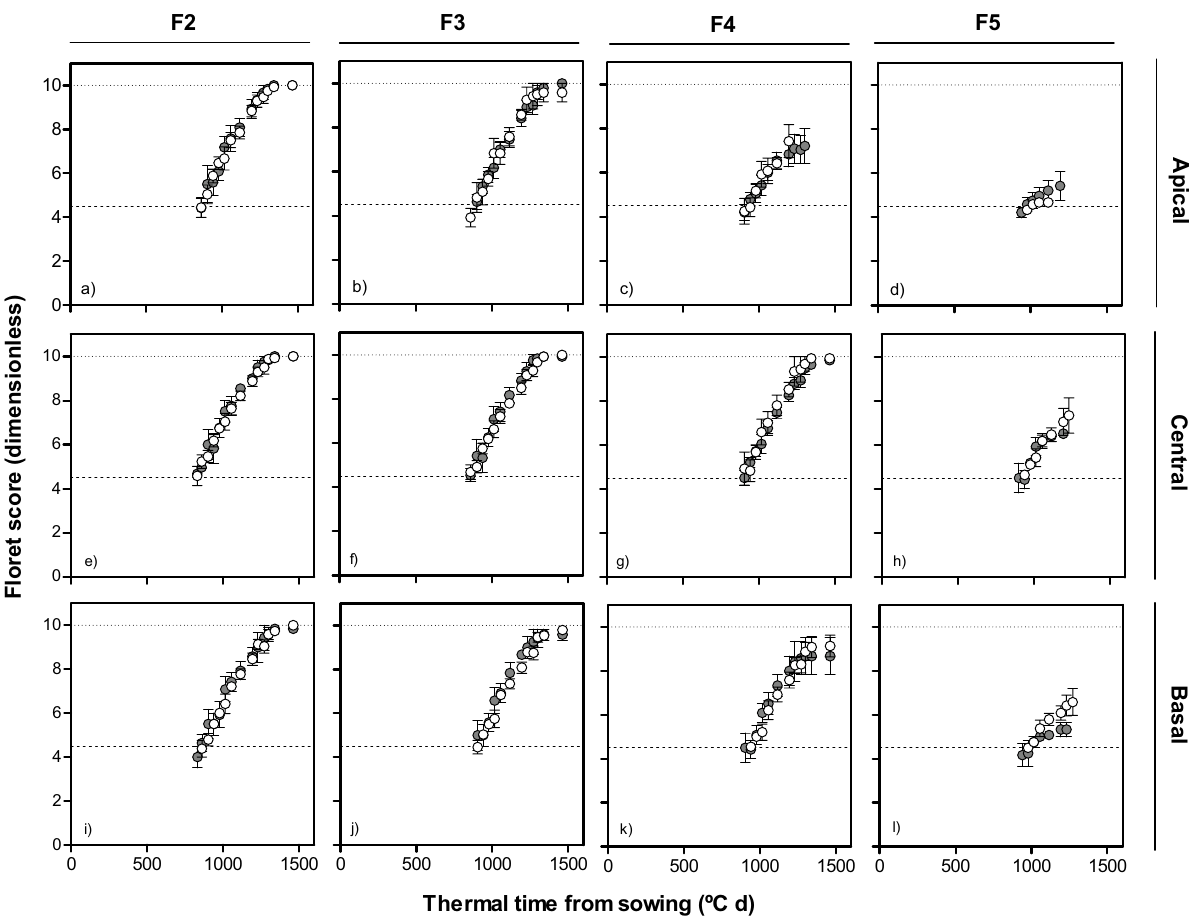
Figure 6. Dynamics of floret development (floret score) in F2, F3, F4 and F5 florets at apical (top panels: a – d ), central (middle panels: e – h ) and basal (bottom panels: i – l ) positions of the spike with thermal time from sowing in lines with Eps-7D-late (open symbol) and early (closed symbol) allele with Eps-2B-early allele in the background in the first cropping